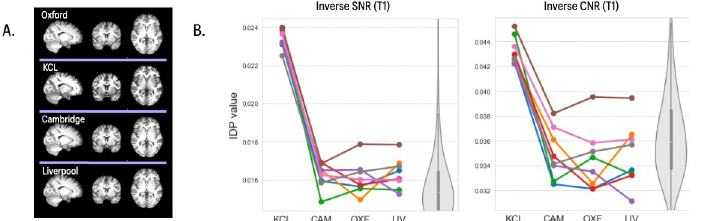
for 8 subjects (coloured lines) scanned at each of 4 sites (x-axis labels); right panel , plots of inverse contrast-to-noise ratio (iCNR) for the same subjects and sites. The grey violin plots in both panels indicate the equivalent distributions of T1 iSNR and iCNR, respectively, in the UK Biobank reference dataset, using matched random sampling of N = 8 participants. Box and whiskers represent inter-quartile range and 95% confidence intervals respectively. The iSNR and iCNR metrics are comparable across Siemens sites (CAM = Cambridge, OXF = Oxford, LIV = Liverpool) and aligned with the UKB benchmark distribution. Both iSNR and iCNR are higher for the GE site (KCL = Kings College London) ( P < 0.05), indicating lower SNR and